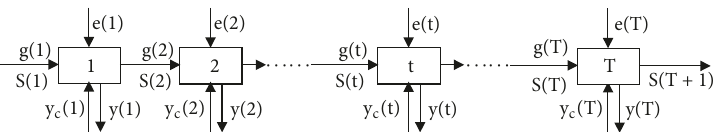
Figure 3: Multi-period production and emission reduction process.